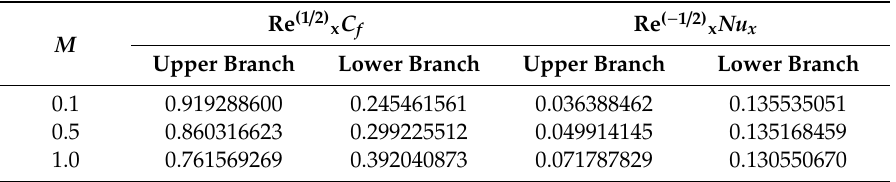
Table 2. Variation of Re (1 / 2) x C f and Re ( − 1 / 2) x Nu x with Pr = 1, ε = 1000, Q = 0.1 dan λ = − 1.2.